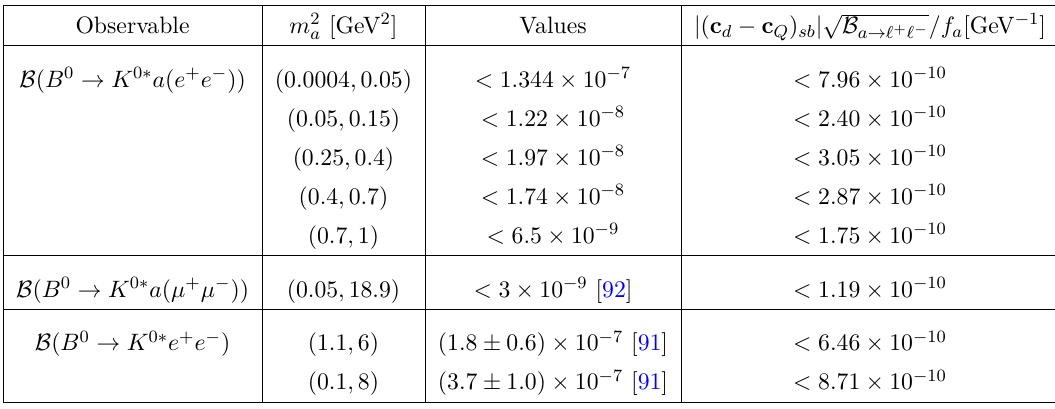
Table 2. Constraints on the ALP-quark coupling from B → K ∗ ‘ + ‘ − and B → K ∗ a ( a → ‘ + ‘ − ) decay processes used in the following figures of this section. The bounds in the last column are expressed at the 2 σ level. For each bound, the value of m considered lies in the middle of the a corresponding energy bin window. The values presented in the third column are those in table 1 and are copied here for